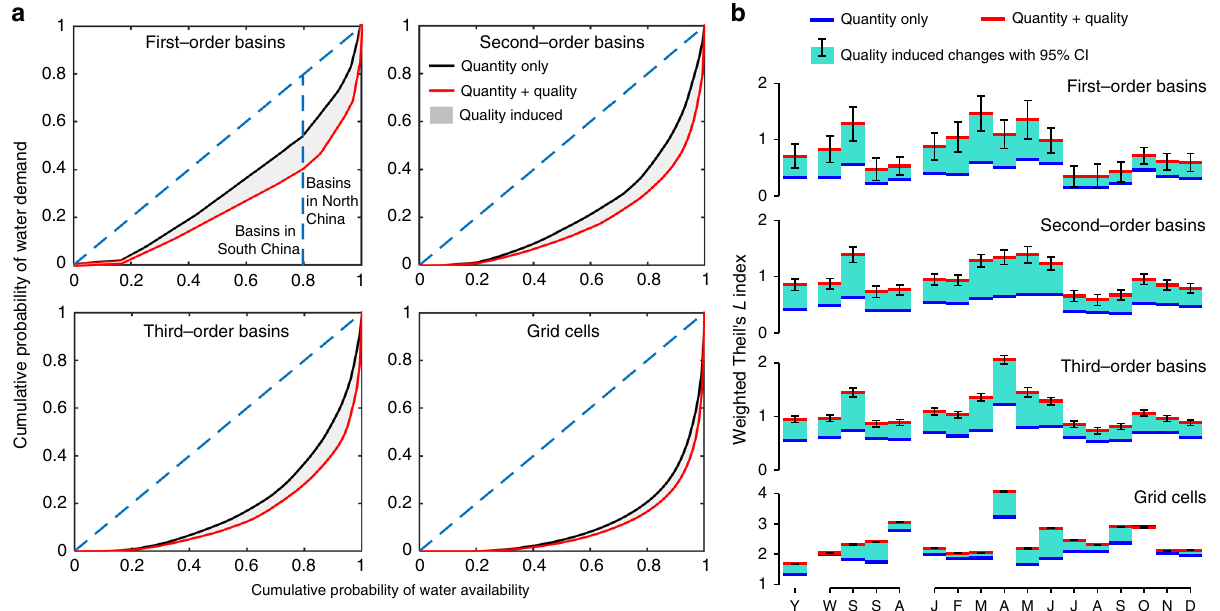
Fig. 5 Regional inequality of water scarcity. a Cumulative probability of water availability against cumulative portability of water withdrawals on the annual basis, sorted by increasing magnitudes of the ratio of water withdrawal to availability according to different geographic scales. b Disparities in water scarcity levels among regions. Theil ’ s L index is used to indicate regional water scarcity disparities, and the 95% con fi dence interval (CI) of Theil ’ s L index was calculated based on the normal approximation (Y, yearly; W – A, seasonal from winter throughout autumn; and J – D, monthly from January